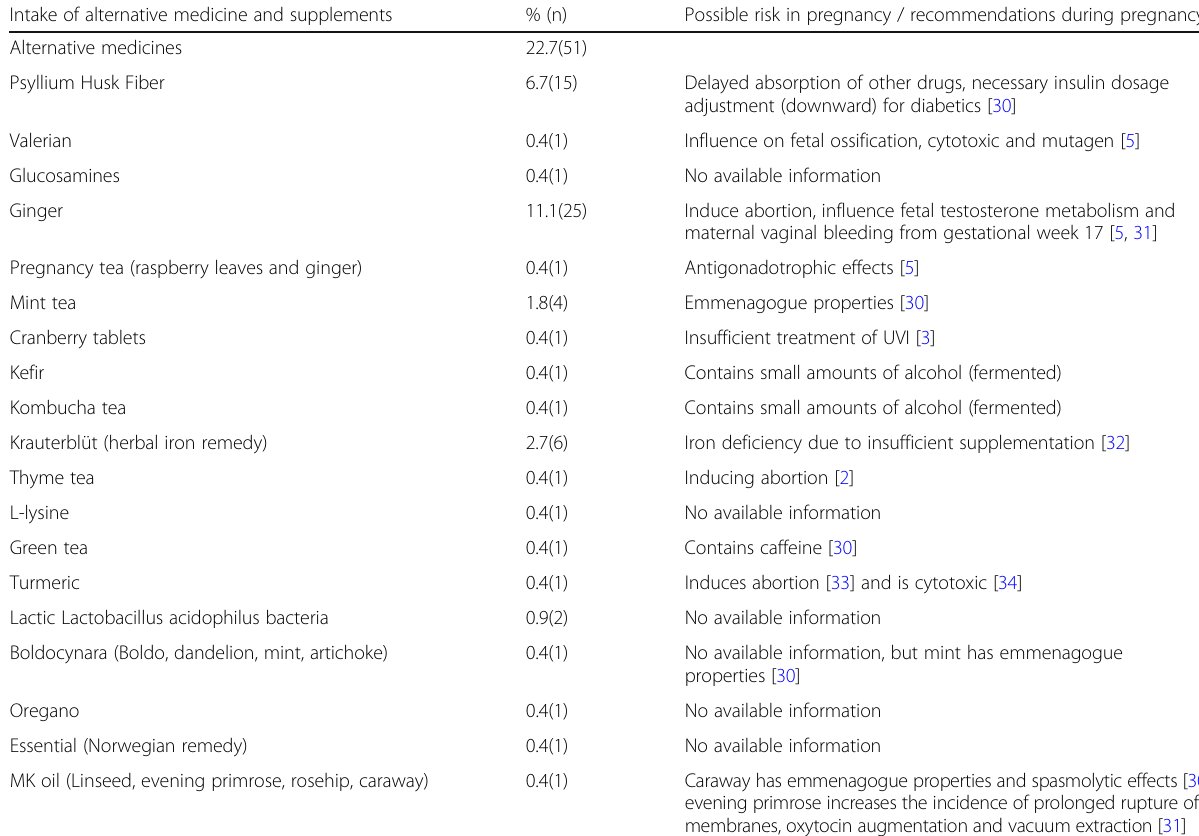
Table 3 Consumption of alternative medicine and herbal